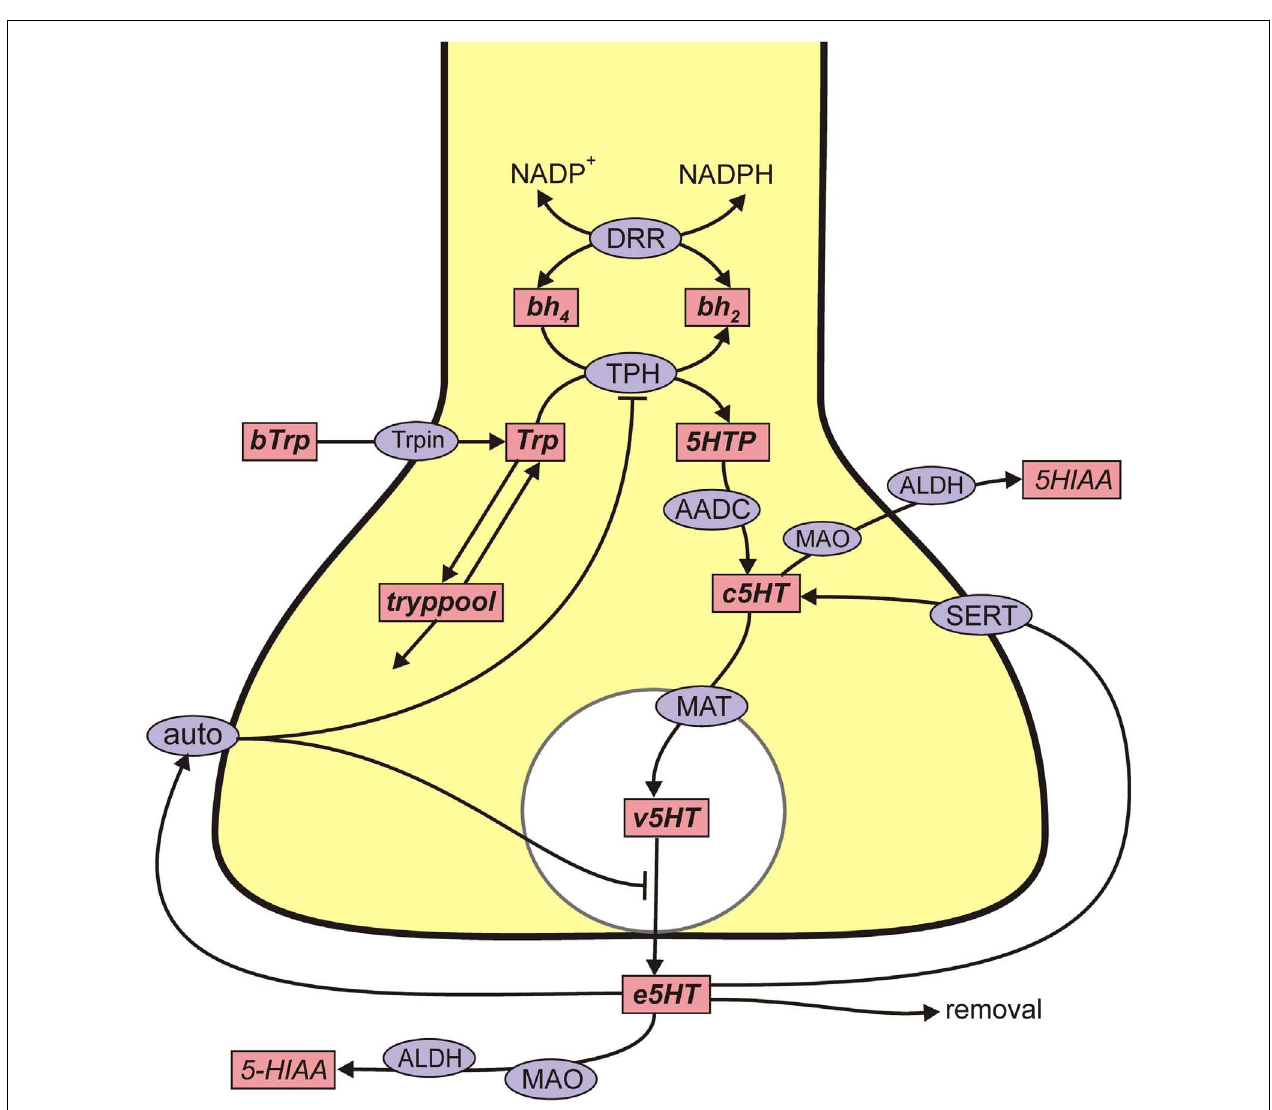
FIGUREA2 | 5HT metabolism in a 5HT terminal. Rectangular boxes indicate substrates (see TableA1 ) and blue ellipses contain the acronyms of enzymes or transporters: V Ltryp , L-amino acid transporter; DRR, dihydrobiopterin reductase;TPH, tryptophan hydroxylase; AADC, aromatic amino acid decarboxylase; MAT, vesicular monoamine transporter; SERT,